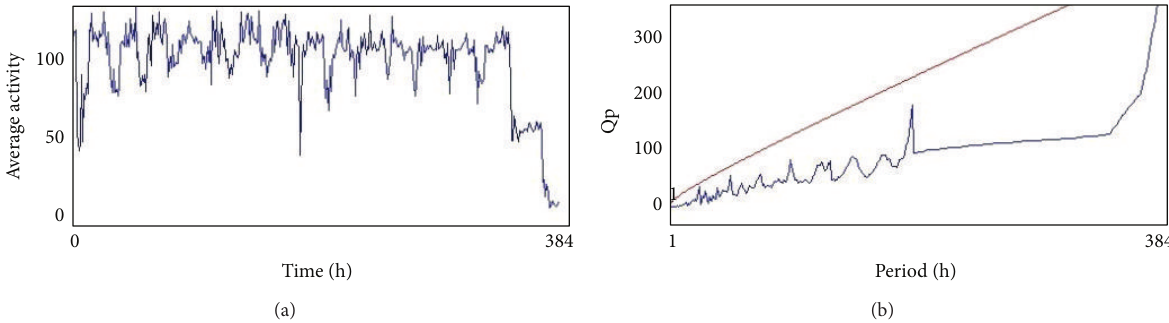
Figure 12: (a) and (b) show the average activity pattern and chi-square periodogram, respectively, for the control flies exposed to 0.50 𝜇 L/mL of Centella asiatica leaf extract in diet ( 𝑁 = 20 ).